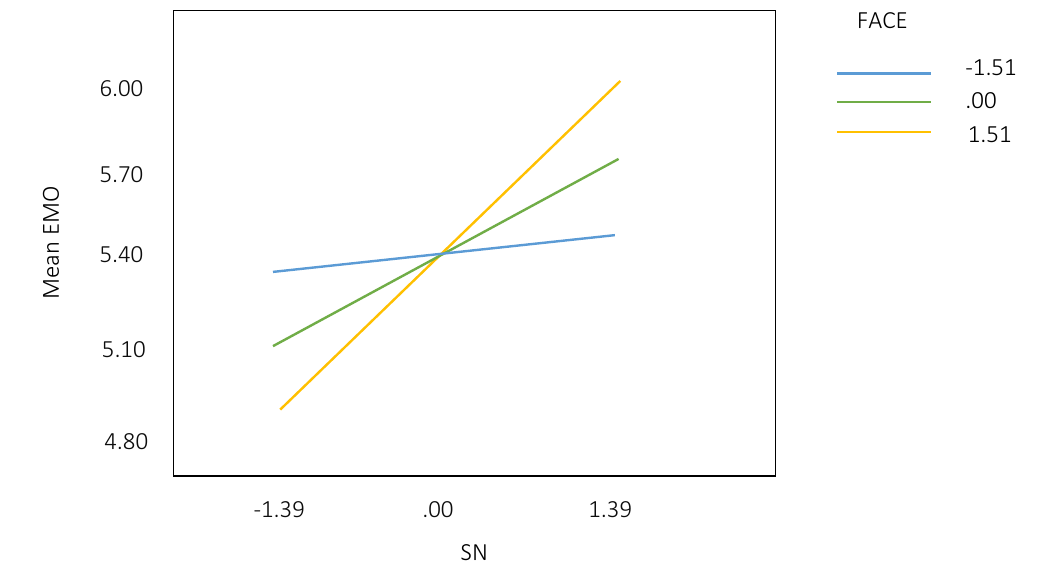
Figure 2. Moderating effects of face consciousness on the relationship between subjective norm and purchase intention (through emotional